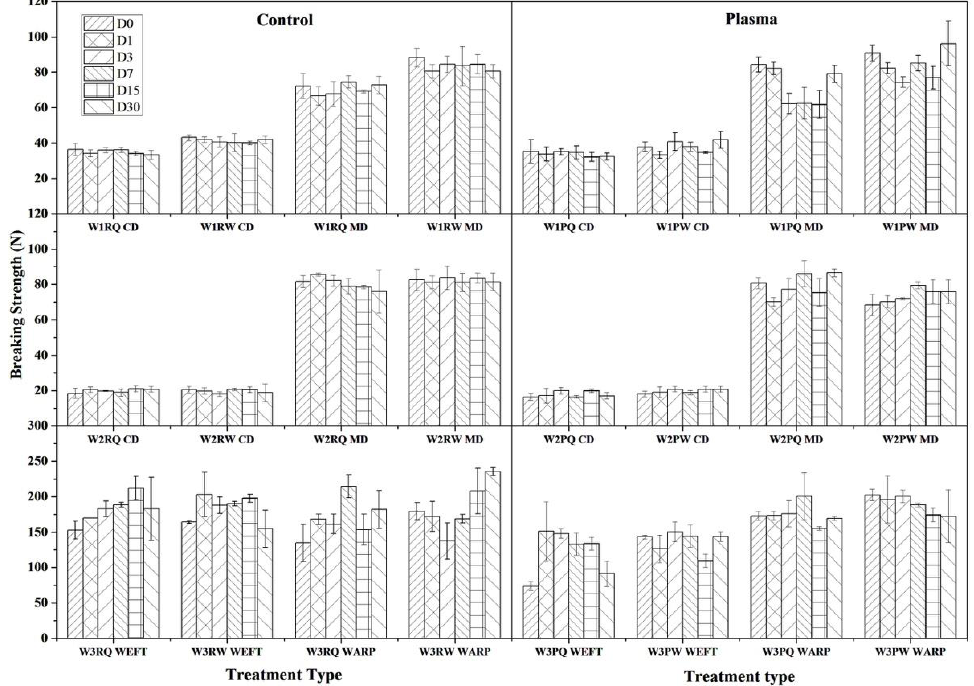
Figure 3. Breaking force (N) change of control (R) and plasma-treated (P) wipe samples during 30 days of storage time. (D0 to 30 represented 30 min, 1, 3, 7, 15, and 30 days’ immersion time) .